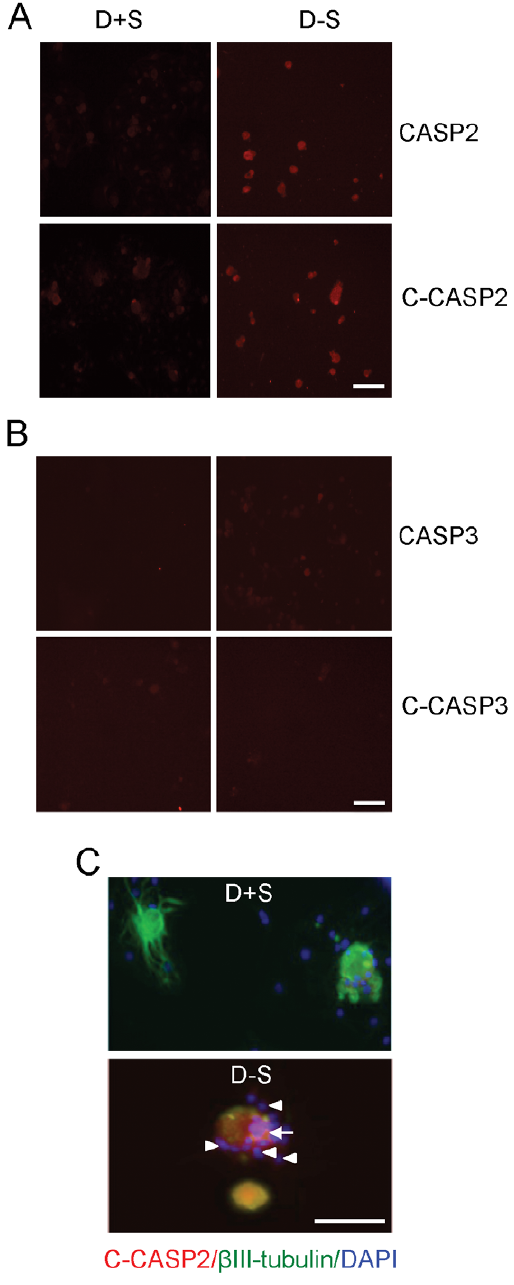
satellite cells. A , CASP2, C-CASP2 and B , CASP3, C-CASP3 in DRGN and satellite cells grown in the presence of serum (D + S) or after serum withdrawal (D 2 S). C , Double immunostaining for C-CASP2 in b III- tubulin + DRGN (arrow) and C-CASP2 + in b III-tubulin 2 satellite cells (arrowheads). Scale bars in A – C =50 m m.